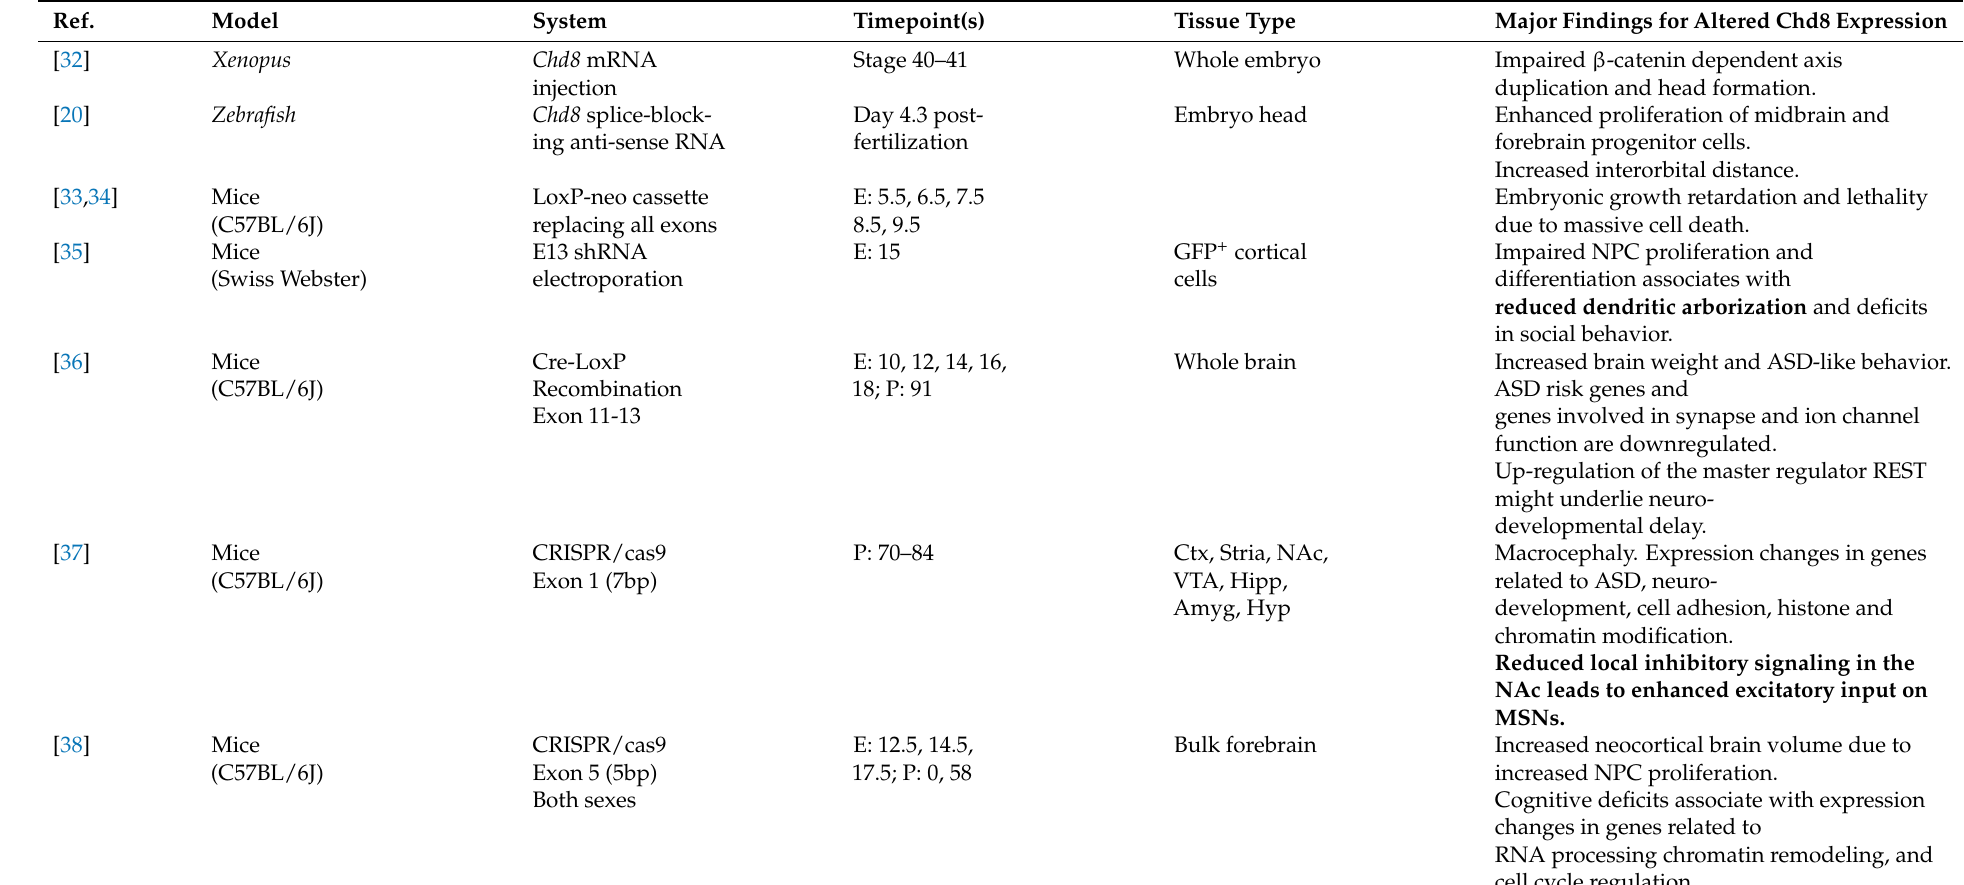
Table 1. Transgenic animal studies on Chd8 function in the developing and mature